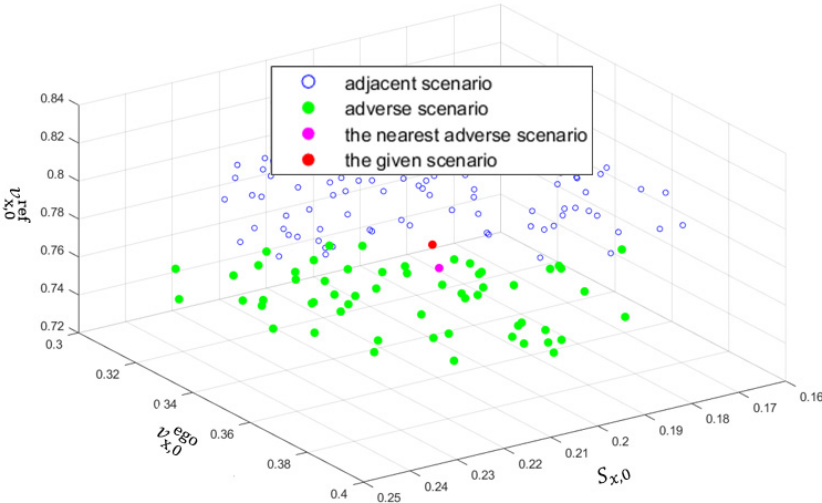
Figure 1. The given scenario and its adjacent, adverse scenarios and the nearest adverse scenario. Blue circles are adjacent scenarios; Green circles are adverse scenarios; The pink circle is the nearest adverse scenario to the given scenario. The red circle is the given scenario.